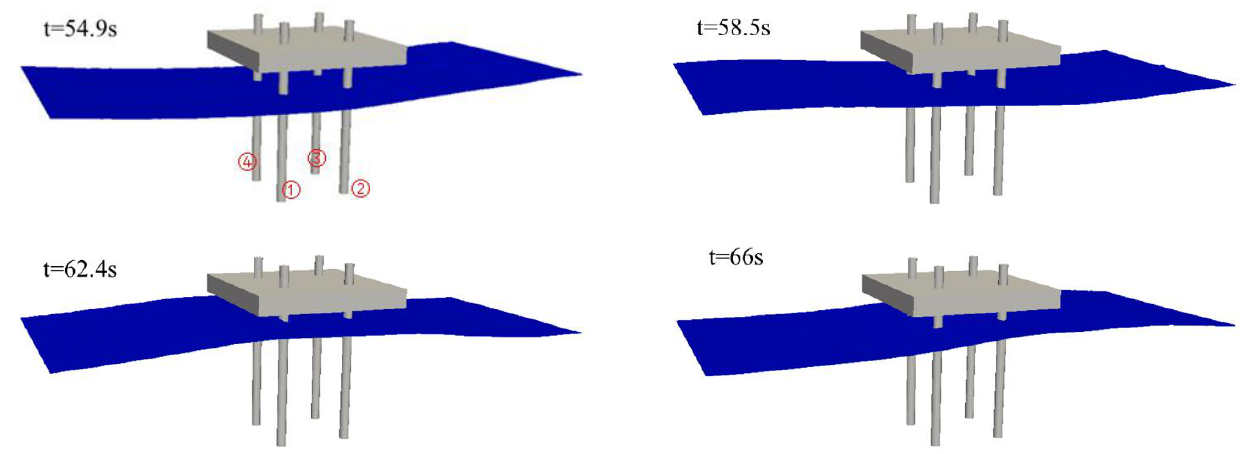
Figure 5. Wave profiles at four typical times during one wave period around the jack-up